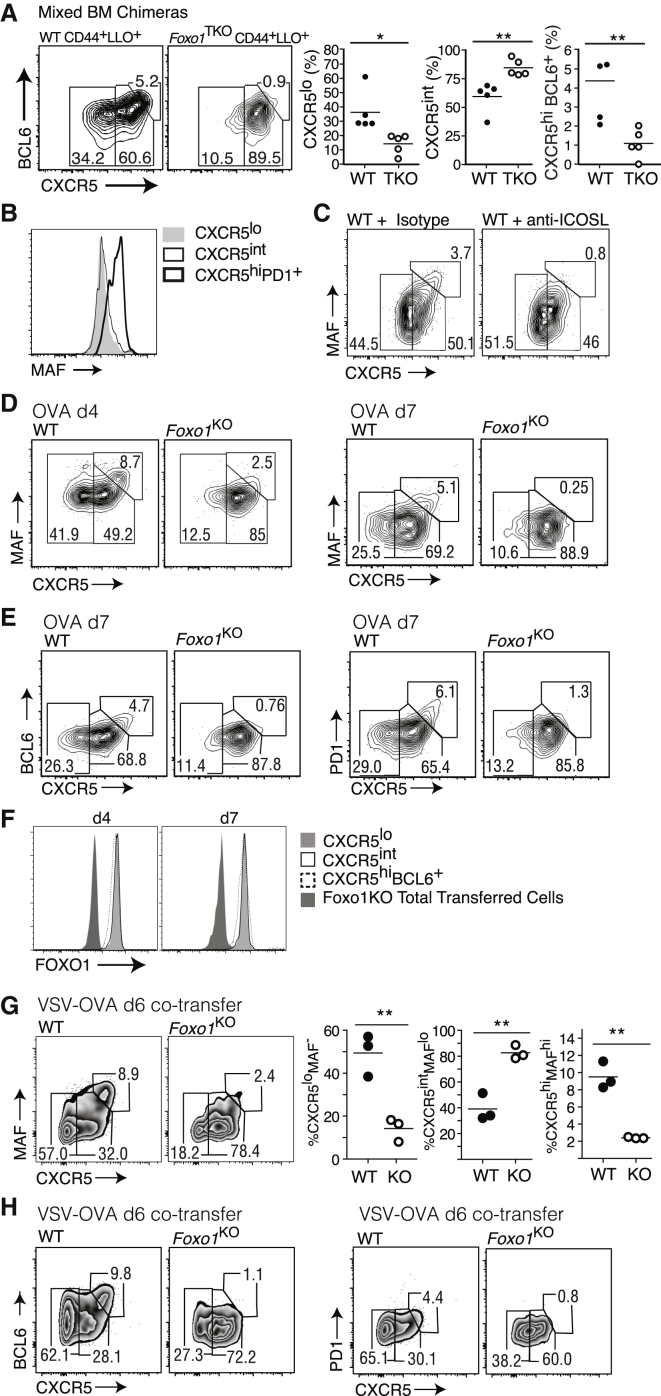
FOXO1 KO T Cells Have Reduced Ability to Differentiate into GC-Tfh Cells(A) Mixed bone-marrow chimeras (WT-CD45.1 and Foxo1TKO) were infected with ΔActA-Lm. CD4+B220-CD44hiLLO+ cells were phenotyped from each donor. Representative of two separate experiments.(B) MAF expression within CXCR5lo, CXCR5int, or CXCR5hiPD1hi OTII T cells day 4 post immunization (n = 3). Representative of three independent experiments.(C) Percentages of CXCR5lo, CXCR5int, and CXCR5hiMAFhi subsets within CD4+ WT OTII T cells day 4 post immunization in the presence or absence of blocking anti-ICOSL. Representative of four host mice per condition.(D) Analysis similar to (C) using WT or Foxo1KO OTII cells assayed at day 4 (n = 3–5) and day 7 (n = 3). One of at least two representative experiments.(E) Plots show CXCR5 versus BCL6 (left) or CXCR5 versus PD1 (right) at day 7 post immunization. One of two representative experiments.(F) Expression of FOXO1 in CXCR5lo, CXCR5int, and CXCR5hiBCL6+ subsets of WT OTII cells at day 4 and day 7 post immunization.(G) The proportions of CXCR5lo, CXCR5int, or CXCR5hiMAF+ cells at day 6 post VSV-OVA infection from co-transferred WT and Foxo1KO OTII T cells. Data are representative of two independent experiments.(H) Plots show CXCR5 versus BCL6 (left) or CXCR5 versus PD1 (right) expression from cotransferred WT or Foxo1KO OTII T cells at day 6 post VSV-OVA infection (as in G). Data are representative of two independent experiments.